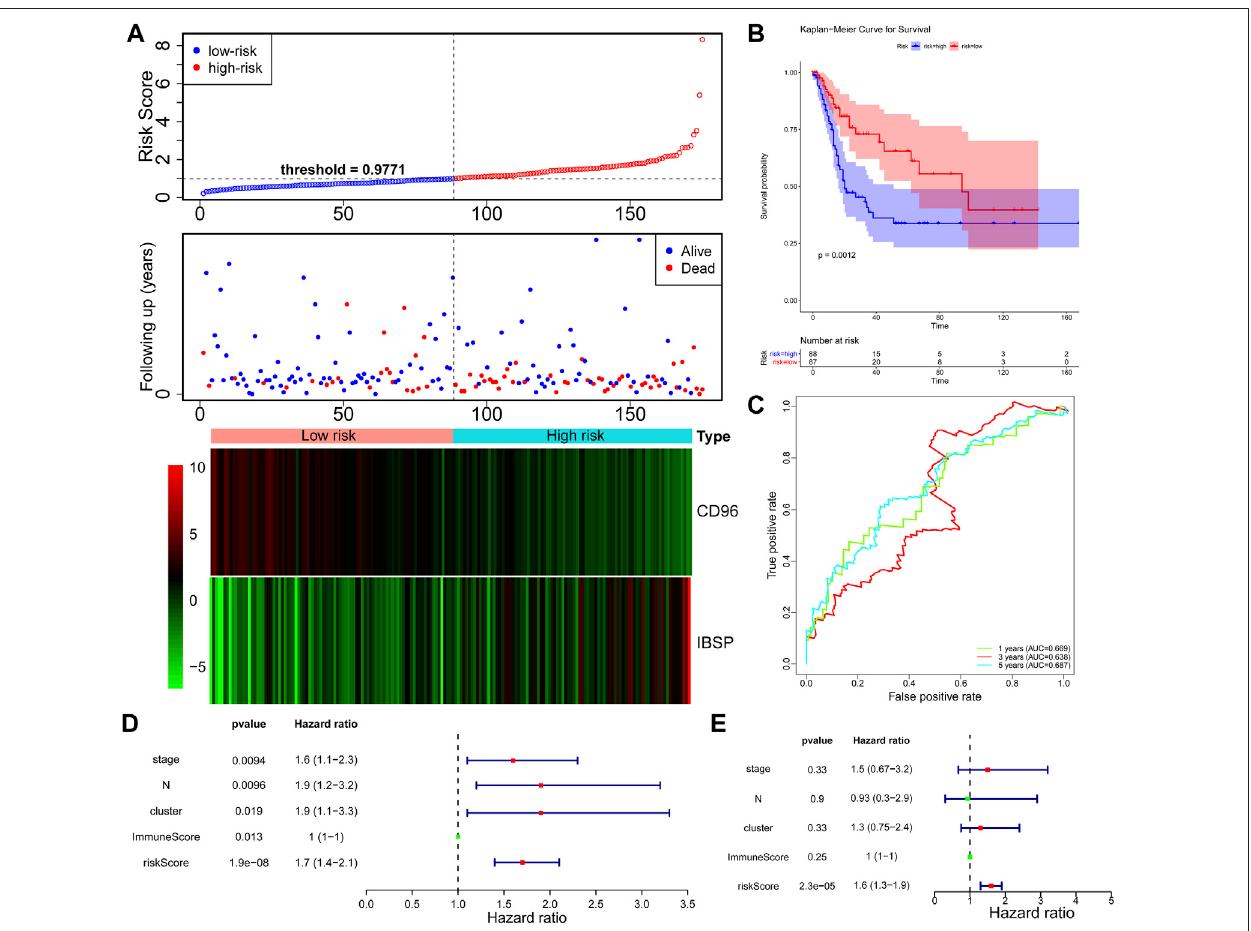
FIGURE 3 | Construction of the DEG-based signature based on the TCGA dataset. (A) Distribution of the risk score, the associated survival data and heatmap of prognostic gene expression in the TCGA dataset. BLCA samples were divided into the high- and low-risk groups according to the median value of the risk score in the training set (threshold = 0.9771). (B) Survivalanalysisofpatientsin thehigh- and low-riskgroups, which wereestablished according tothe abundance ofthe prognostic DEGs. (C) TheAUCwasusedtomeasurethepredictiveaccuracyofthe2-genesignatureat5 years(AUC=0.817). (D) Univariateanalysiswasperformedwiththe risk score and each clinical feature. (E) Subsequent multivariate Cox regression analysis showed that the risk score was the only independent risk factor for poor prognosis in BLCA patients.